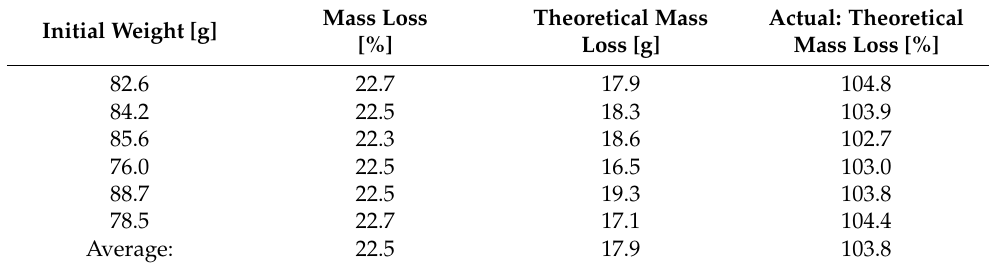
Table 4. Initial weight and mass losses during sintering.